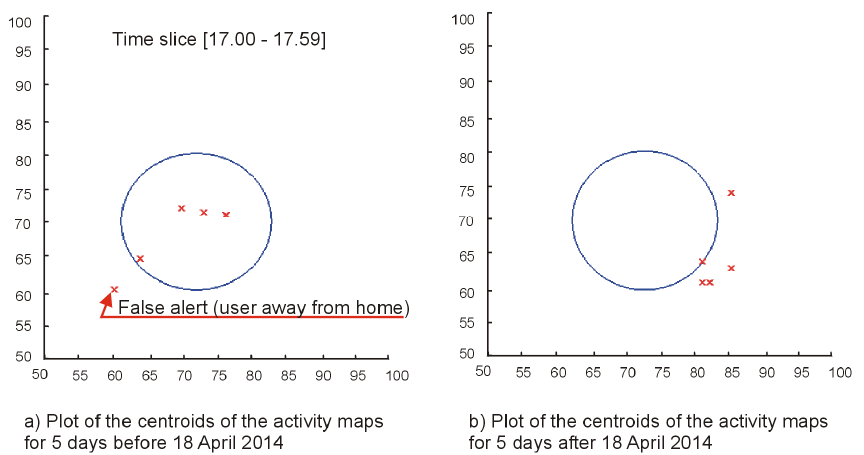
Figure 10. CASAS HH-126 dataset: Plot of the centroids of the activity maps for the time slice (17.00–17.59). ( a ) Five days before 18 April 2014 ( b ) Five days after 18 April 2014. The circle is the SBC of the centroids of the activity maps created for the same time slice during the reference interval (01.02.2014–10.04.2014).